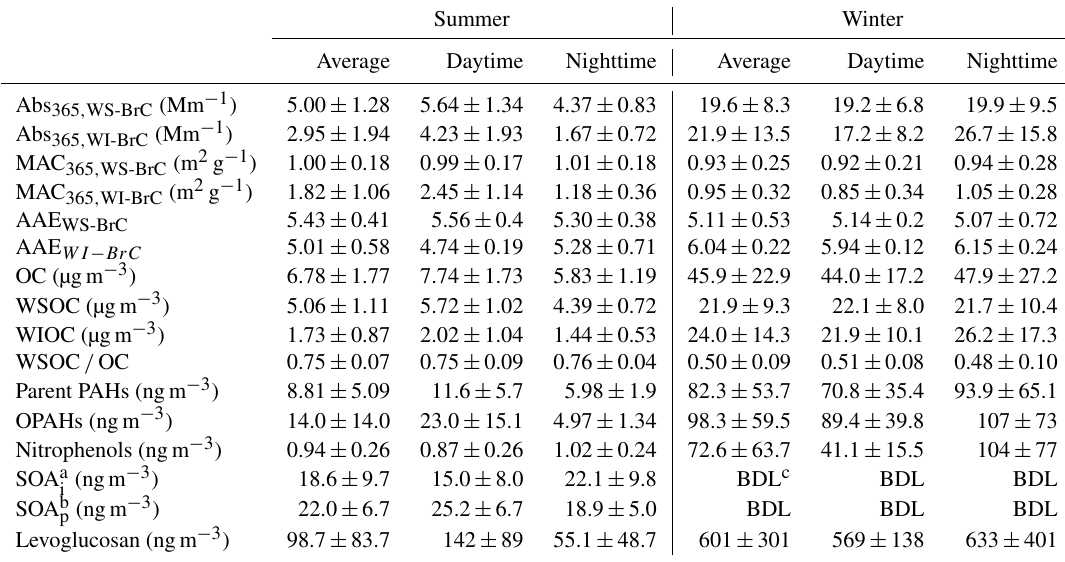
Table 1. Average ( ± 1 σ ) values Abs 365 , MAC 365 and AAE of WS-BrC and WI-BrC, as well as concentrations of OC, WSOC, WIOC and measured organic species in the PM 2 . 5 aerosols from the rural site in the Guanzhong